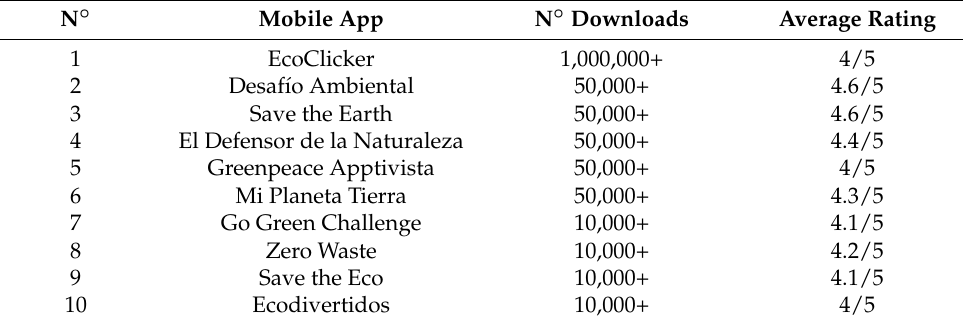
Table 1. Mobile apps selected from Google Play and AppStore. N ◦ Mobile App N ◦